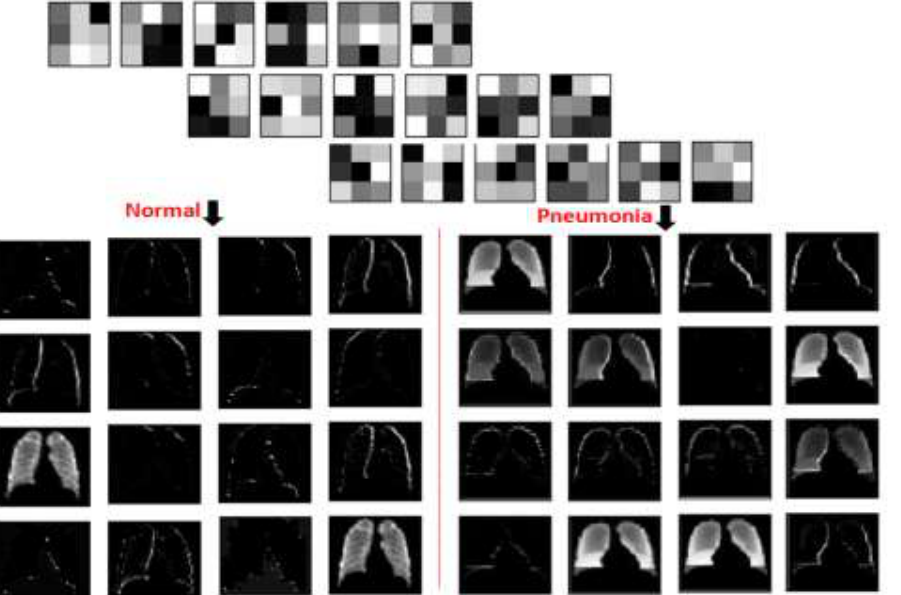
Figure 8. The applied 3 × 3 filter and the corresponding 32-item set of extracted features for normal and pneumonia samples, in left and right part of the figure, respectively.